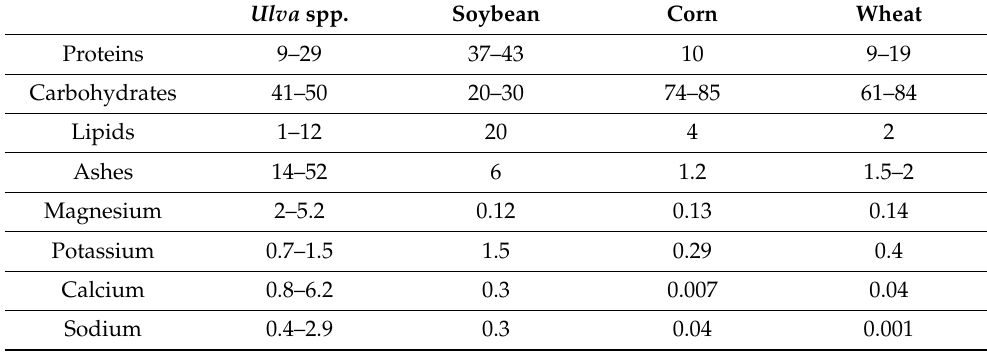
Table 1. Biochemical composition of the macroalgae Ulva spp. and conventional feedstuffs (% Dry Weight). Ulva spp.